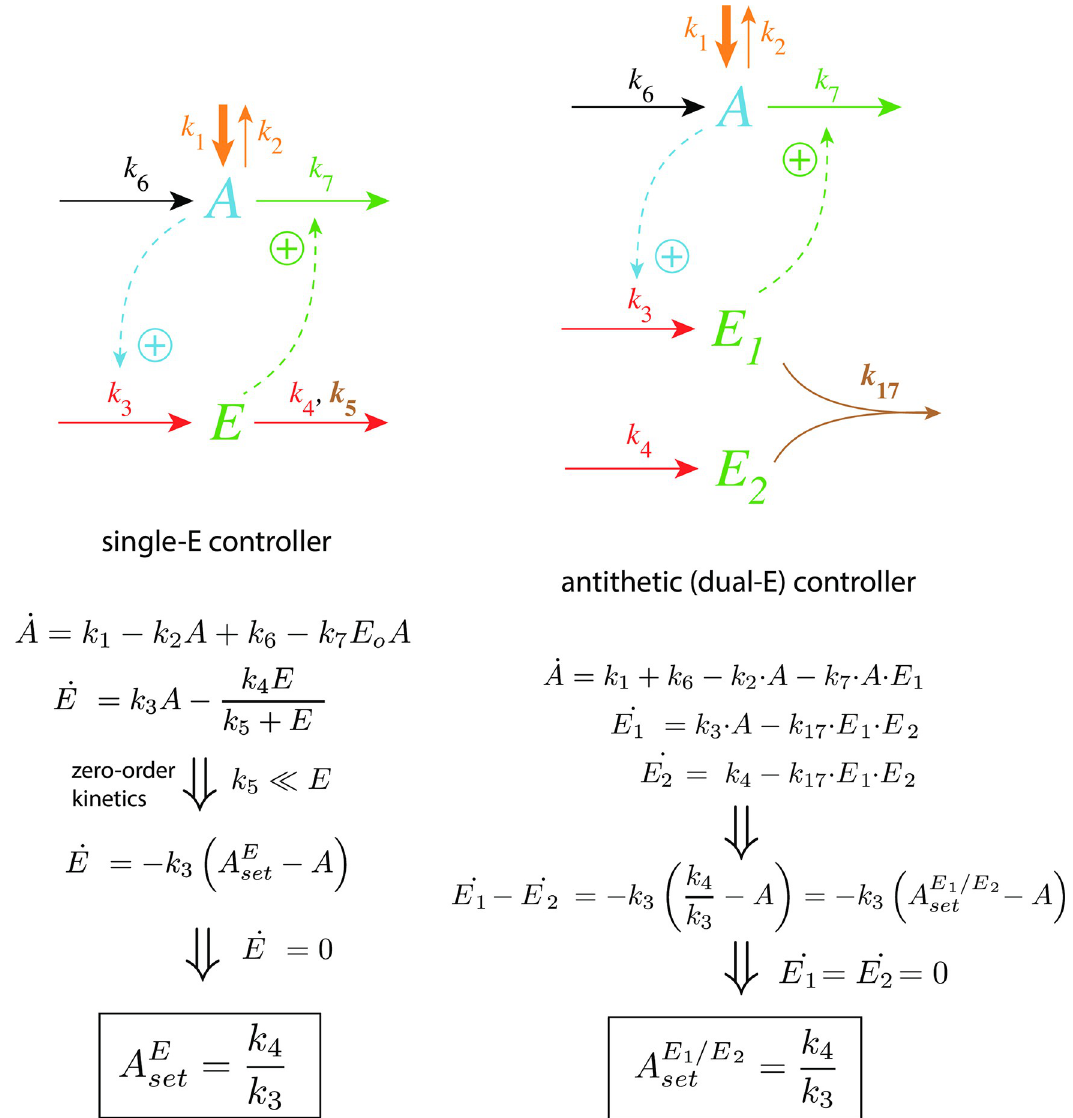
Fig 2. Single-E and dual-E (antithetic) representations of integral control using a motif 5 negative feedback structure. Left panel: Single-E controller where error integration occurs by zero-order kinetics (low k 5 ) removing E [4, 6]. Right panel: Dual-E controller [7, 8, 10] with controller pairs E 1 and E 2 . Error integration occurs by the (here second-order) reaction between E 1 and E 2 . In the single-E controller the concentration of E is proportional to the integrated error A E (cid:0) A . In the antithetic (dual-E) controller, set (cid:0) A . The colorings of the reaction schemes relate to the different the difference E 1 − E 2 is proportional to the integrated error A E 1 = E 2 set parts in the general control loop shown in Fig 1.